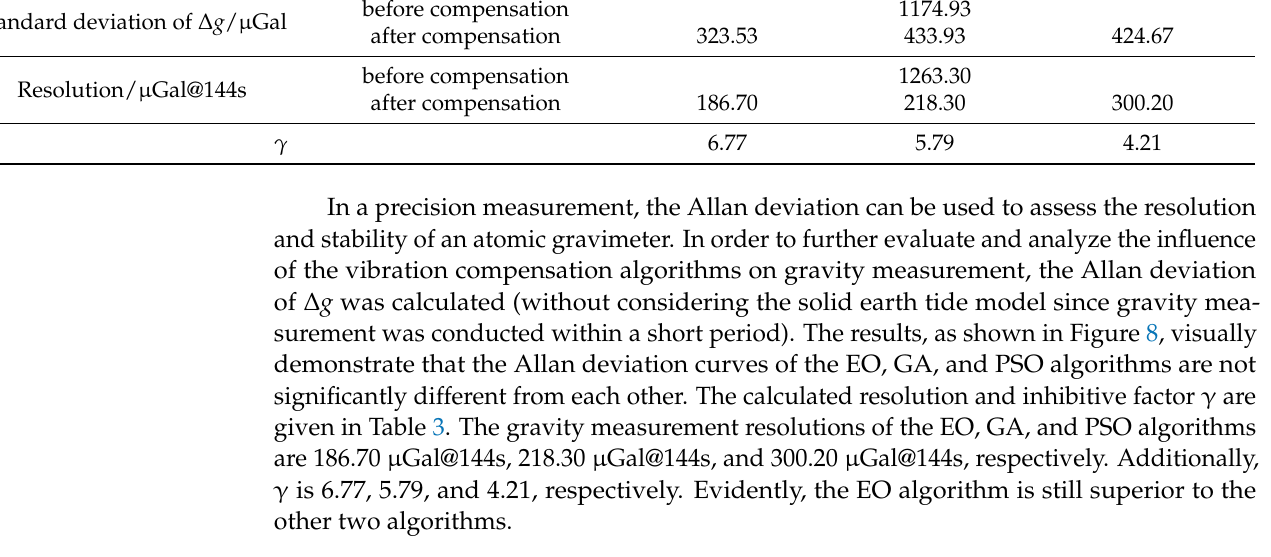
Figure 7. Measurement results after 50 vibration compensations. ( a )